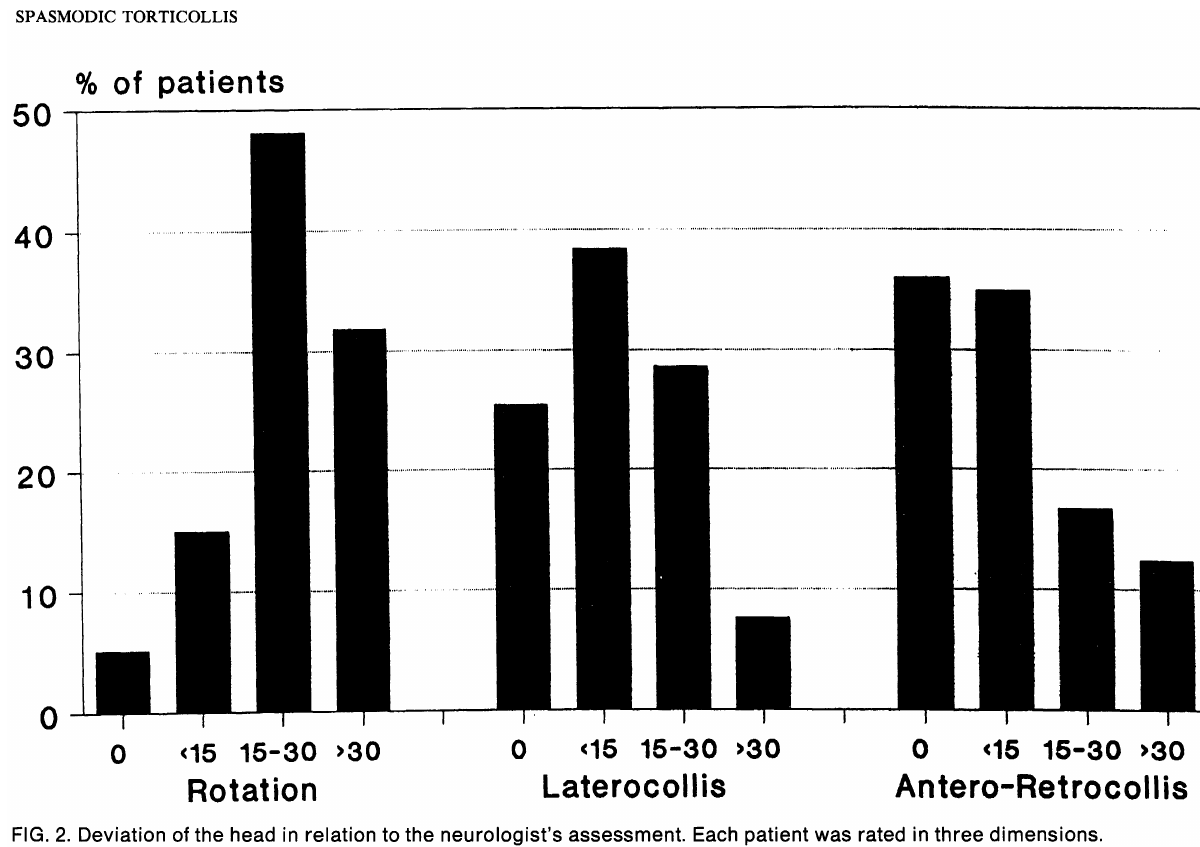
FIG. 2. Deviation of the head in relation to the neurologist's assessment. Each patient was rated in three dimensions.